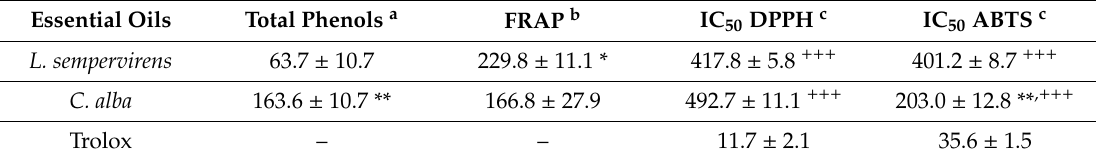
Table 2. Antioxidant capacity of C. alba and L. sempervirens essential oils.